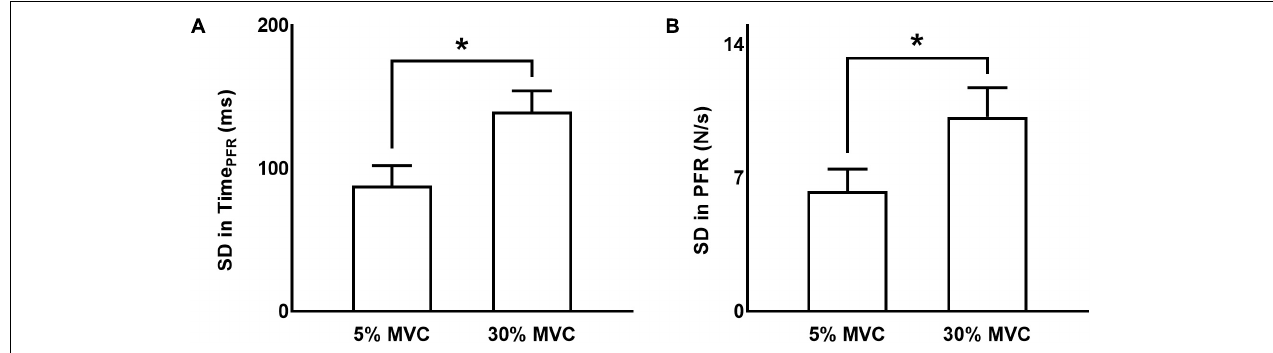
FIGURE 2 | Variability in grip force rate variables. (A,B) Standard deviation (SD) in time to peak force rate and peak force rate, respectively, at 5% and 30% of force. Data are averages across all subjects (vertical bars denote SE). Asterisks indicate p < 0.05.